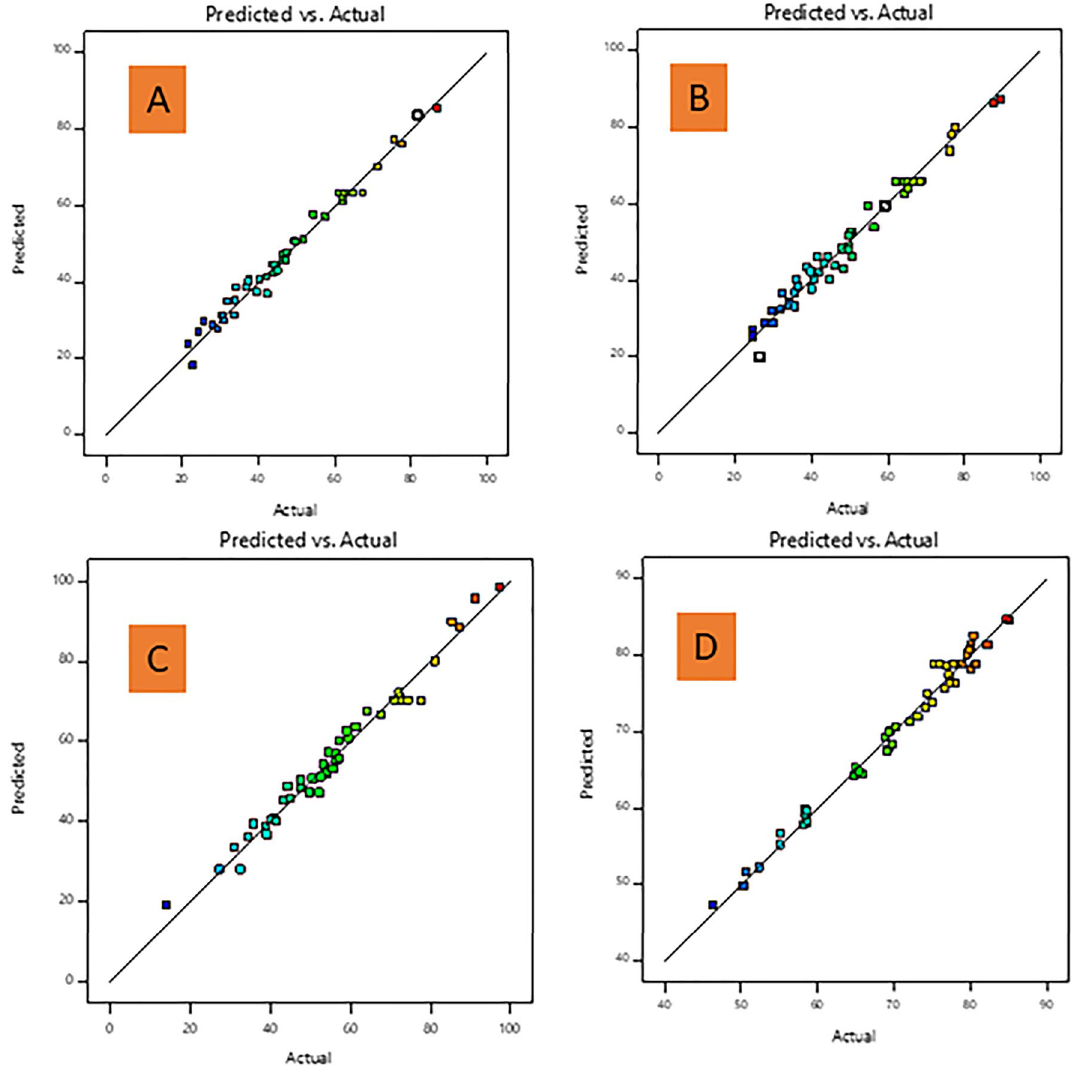
Figure 1. Plot of actual values against predicted values of responses for ( A ) % Fe content of magnetite-oleic acid (MNP-OA) composite, ( B ) benzene, ( C ) toluene, and ( D ) xylene adsorption